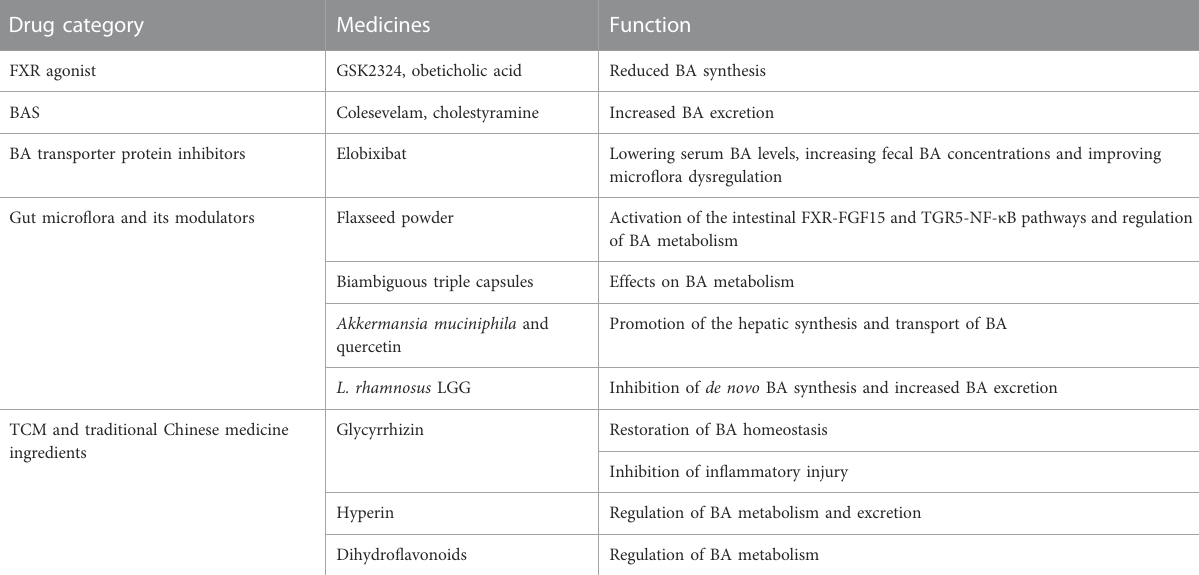
TABLE 1 Drugs and their effects on NAFLD treatment by regulating BA. Drug